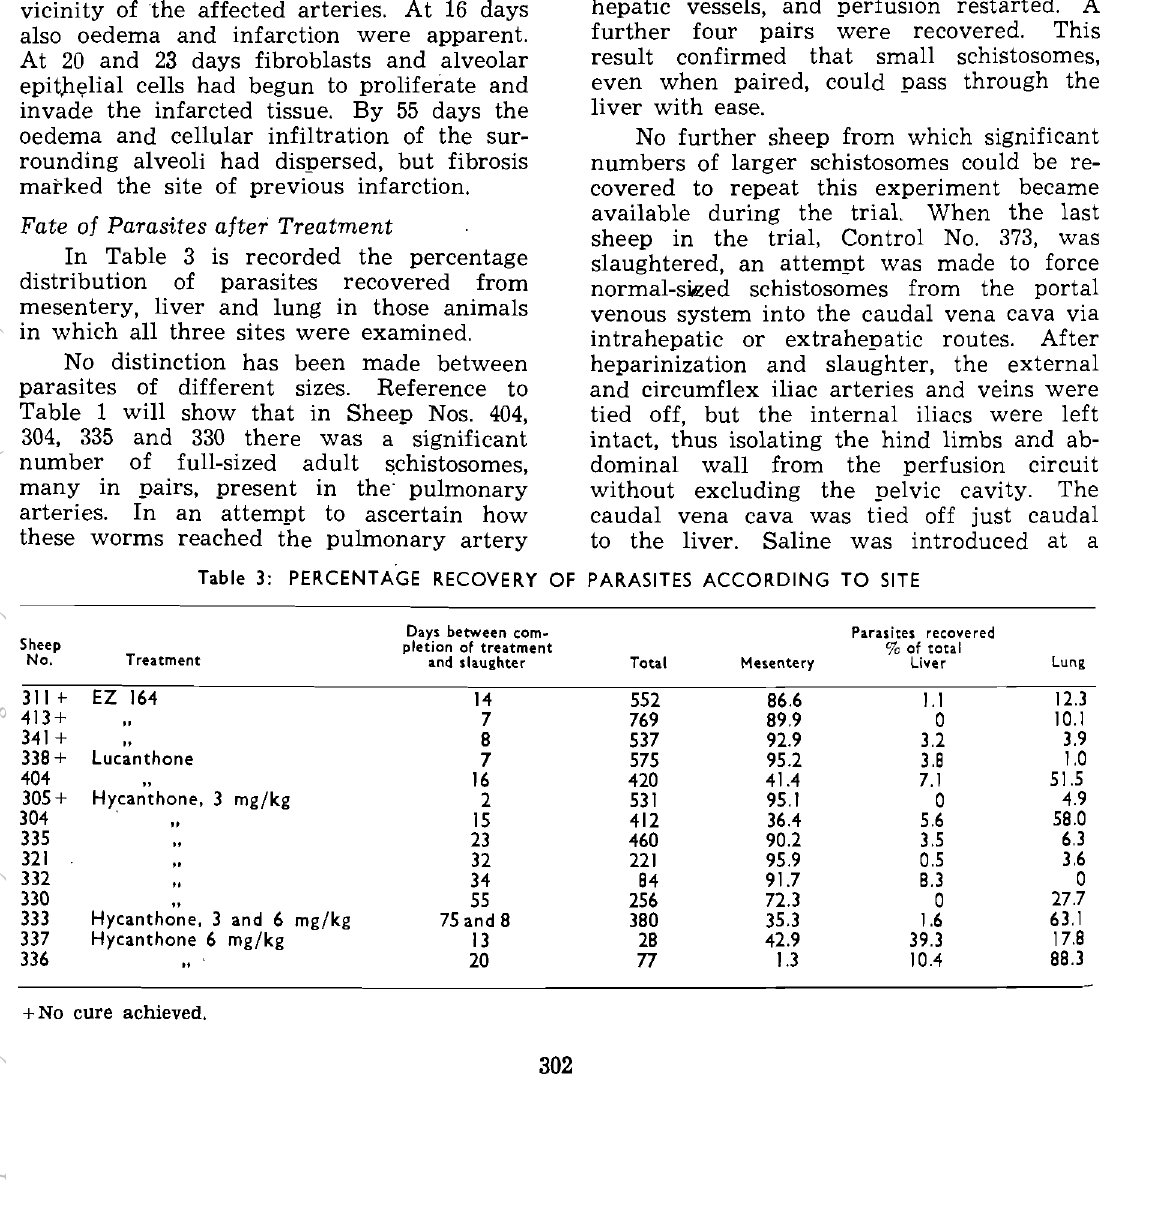
Table 3: PERCENTAGE RECOVERY OF PARASITES ACCORDING TO SITE Days between com- Parasites recovered Sheep pletion of treatment % of total No.